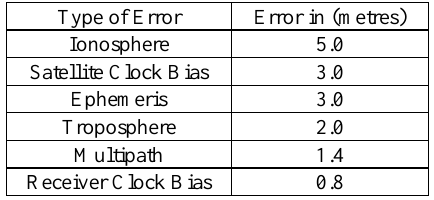
Table 1. GPS Error Budget Table 1 gives numerical information about GPS error